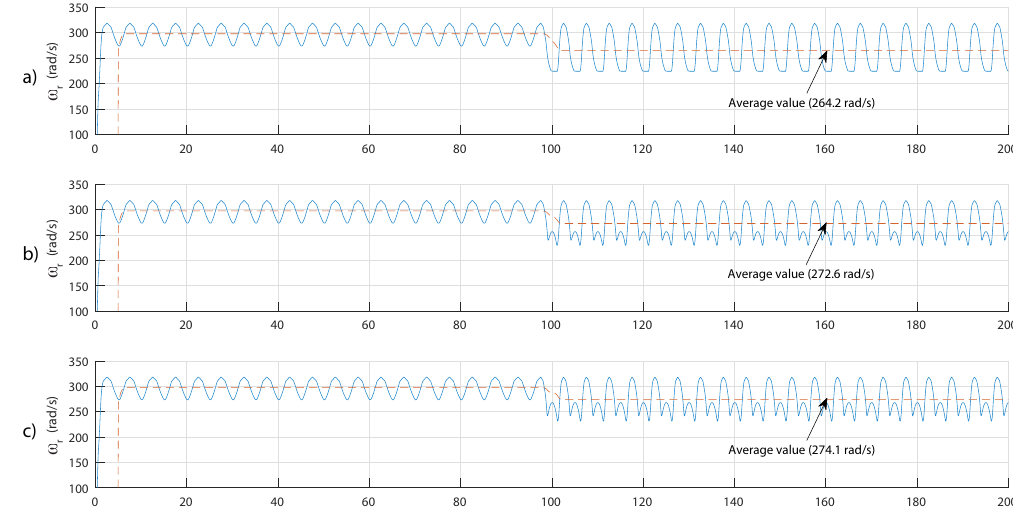
Figure 21. Rotational speed for the OWC. ( a ) Uncontrolled case. ( b ) ANN1-rotational speed control. ( c ) ANN2-rotational speed control.